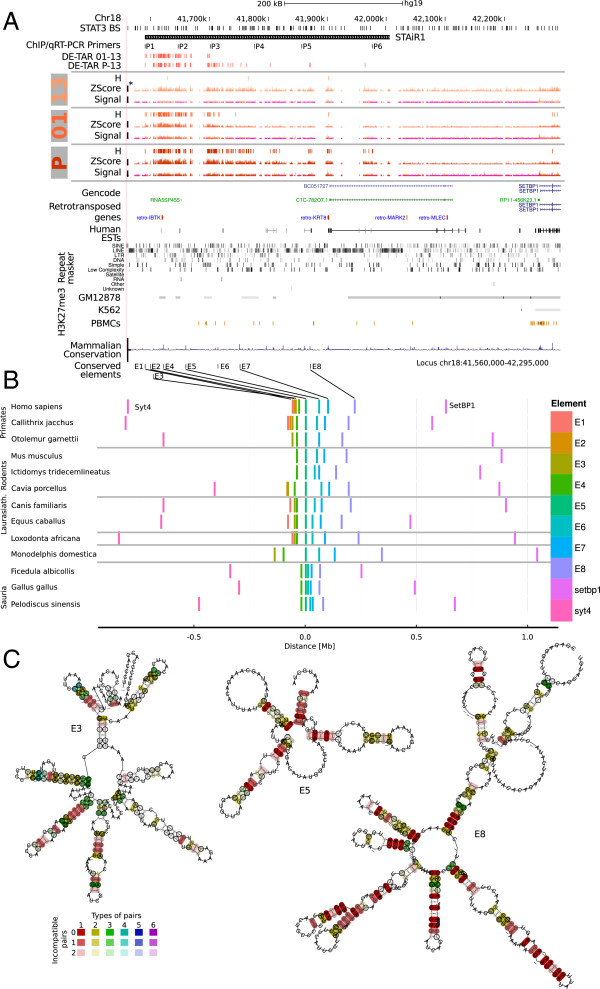
STAiR1 – a STAT3-controlled macroRNA.(A) STAiR1 is upregulated in response to STAT3 and was identified by manual inspection of TileShuffle tracks. After 1 h of restimulation with IL-6 (denoted 01 on the left), TileShuffle detects a 130-kB long region of significant upregulation compared to 13-h IL-6 withdrawn cells (13). In cells permanently cultured with IL-6 (P), the region extends to at least 300 kb. It overlaps H3K27me3 domains in ENCODE data identified in GM12878 lymphoblastoid cells and peripheral blood mononuclear cells (PBMCs) derived from healthy donors, which is missing in K562 leukemia cells [5], and several STAT3 binding sites (STAT3 BS). Please refer to the caption of Figure 1, for a definition of signal, H, and DE-TAR tracks and wiggle track scale bars. (B) STAiR1 contains highly conserved elements. STAiR1 was aligned to all vertebrate genomes provided by Ensembl using BLAST[64]. Several conserved elements throughout STAiR1 that did not overlap annotated repeat elements were selected for further analysis. The chart displays the relative location of elements E1 to E8, arbitrarily aligned by E6 for selected genomes. Hits in additional genomes, including those where no continuous scaffold was available for the interval E1 to E8, are shown in Additional file 1: Figure S14. (C)BLAST hits from (B) were initially aligned using Clustalw[65], submitted to RNAalifold[66] and trimmed to regions of conserved secondary structure. The depicted consensus RNA secondary structures were generated by applying LocARNA[67] followed by RNAalifold to the trimmed sequences. The number of different types of base pairs for a consensus pair, i.e. compensatory mutations supporting the structure, is given by the hue, the number of incompatible pairs by the saturation of the consensus base pair. ChIP, chromatin immunoprecipitation; Chr, chromosome; DE-TAR, significantly differentially expressed transcriptionally active region; EST, expressed sequence tag; kb, kilobase; Laurasiath, Laurasiatheria; MB, million base pairs; PBMC, peripheral blood mononuclear cell; PCR, polymerase chain reaction; qRT-PCR, quantitative real-time reverse transcriptase PCR; STAiR, STAT3-induced RNA; STAT3, signal transducer and activator of transcription-3.